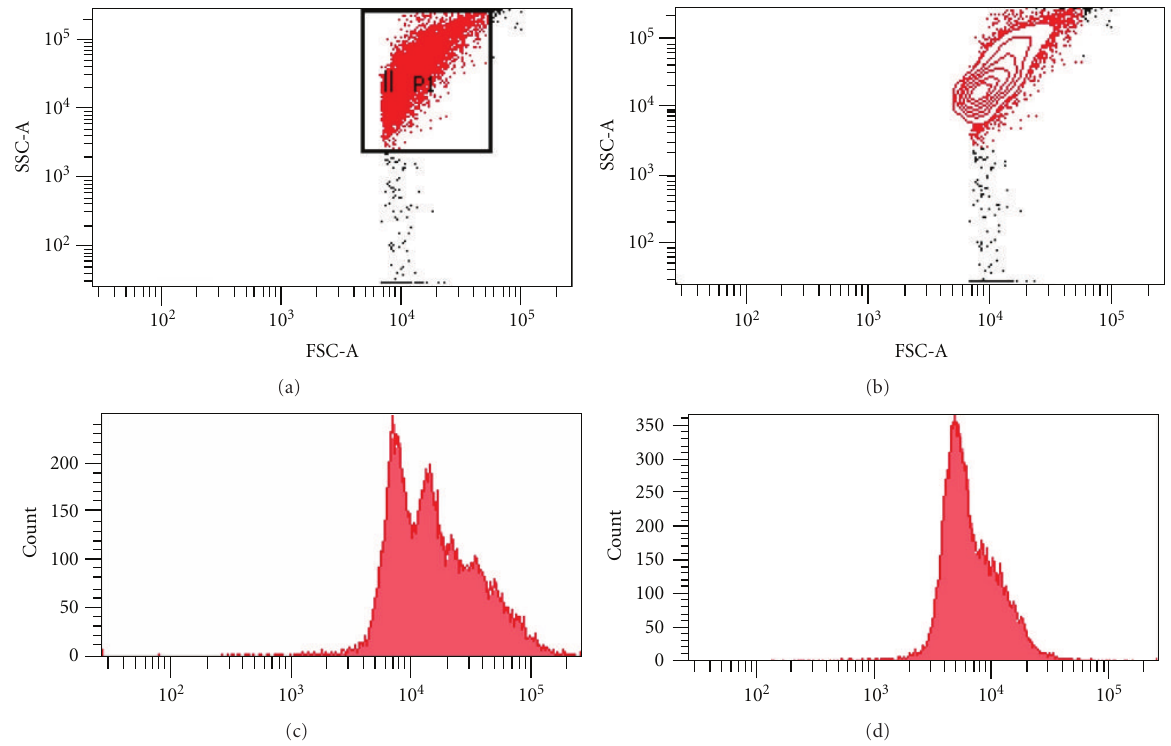
Figure 6: (a) ROI, (b) contour map, (c) β -tubulin III-A, and (d) β -tubulin